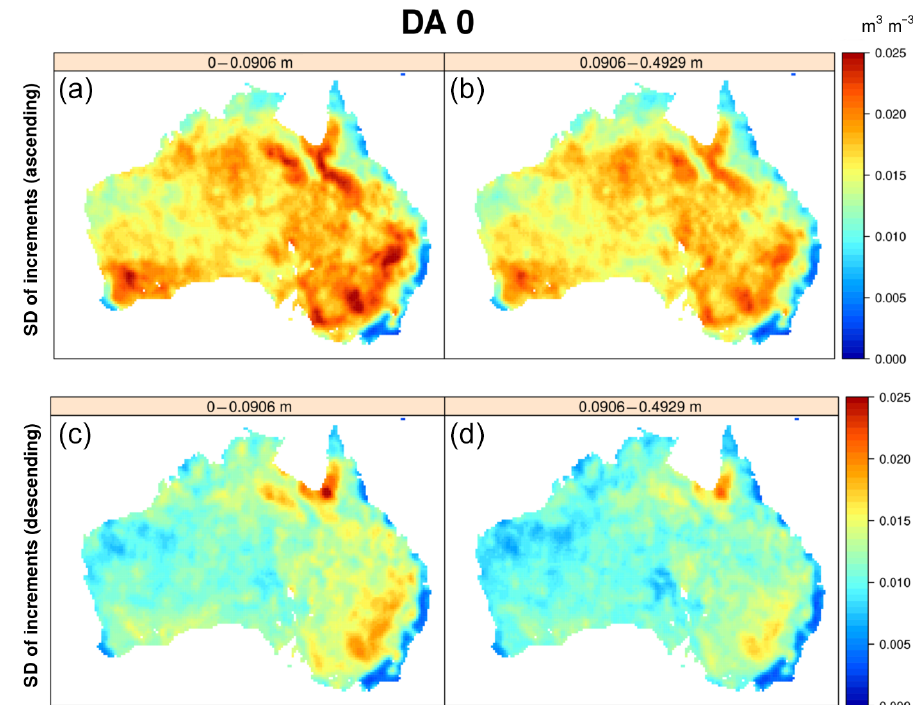
Figure 5. Increments standard deviation of all increments for experiment DA 0 for top-layer soil moisture (a, c) and root-zone soil mois- ture (b, d) for ascending (a, b) and descending orbits (c, d) . Increments for the root-zone soil moisture are fairly similar to the top soil layers, due to the homogeneous texture perturbations applied across all